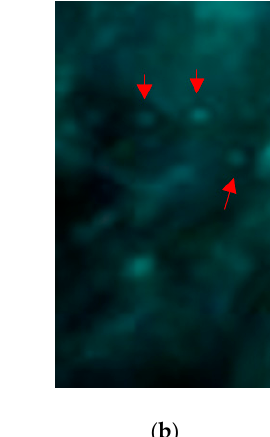
Figure 3. ( a ) Input 2D image, ( b ) image segmented by fuzzy clustering.